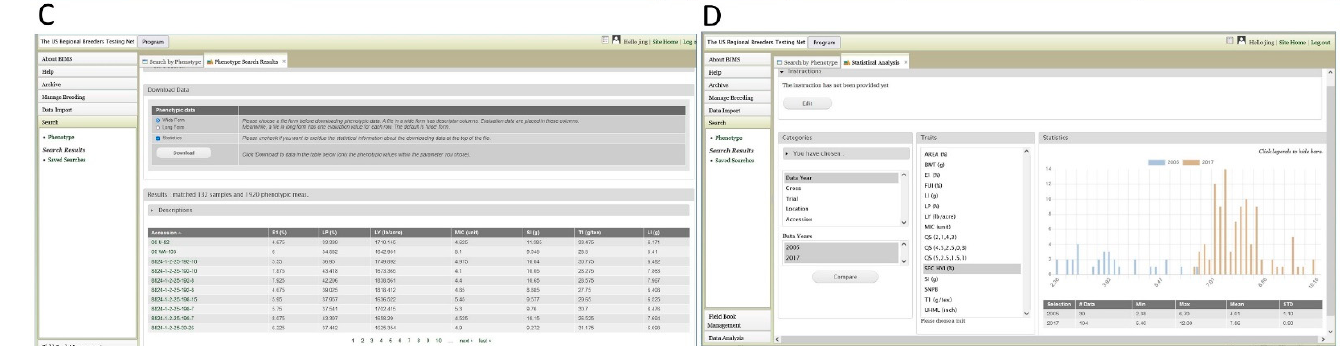
Figure 3. CottonGen BIMS. ( A ) ‘Template List’ subsection in ‘Data Import’ section provides downloadable templates for researchers to enter various breeding data. ( B ) ‘Search’ section allows researchers to search and save the list of accessions using any combination of properties and trait cut of values: accessions name, trial, location, cross, data year, and trait values. The middle section shows the statistical information on the filtered dataset for the trait chosen and the right section shows the number of accessions filtered so far. ( C ) A page with the search result table. Researchers can add more columns in the table using ‘Column options’ and save/download the result table. ( D ) ‘Data Analysis’ section that allows researchers to choose multiple datasets, using the categories or saved accession lists and compare the trait statistics between the da- tasets.